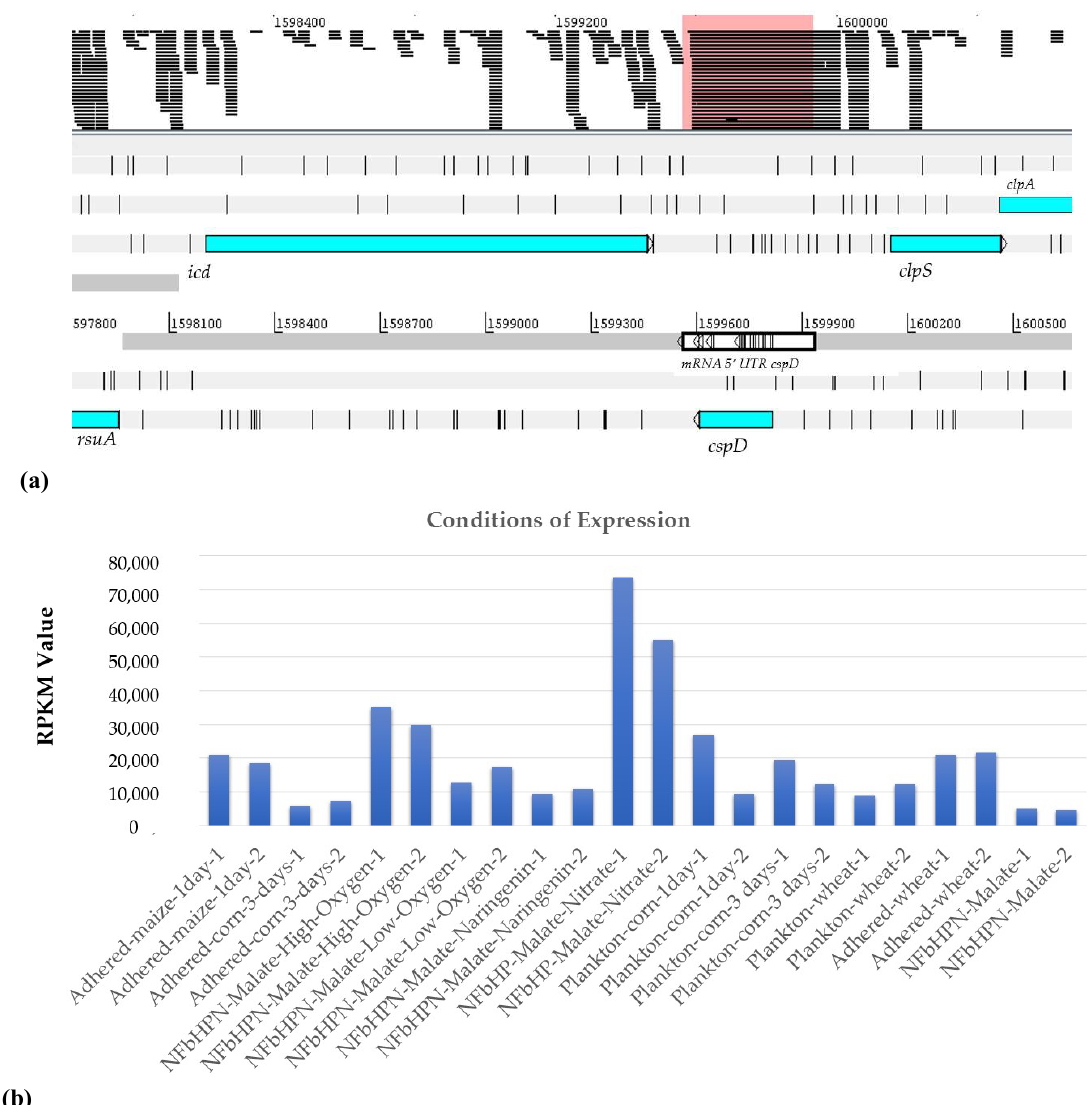
Figure 3. Visualization of the position and expression profile of mRNA 5′ UTR cspA in the genome of H. seropedicae SmR1. The sequence was located with the aid the Artemis program. The readings delineated within the pink rectangle refer to: ( a ) Levels of expression of mRNA 5′ UTR cspA in RNA-seq assays in H. seropedicae SmR1. In the colored part, the 11 analyzed experimental conditions are represented, where 1 and 2 represent d.a.i (days after inoculation); ( b ) the numbers represent the value of the gene expression in RPKM.